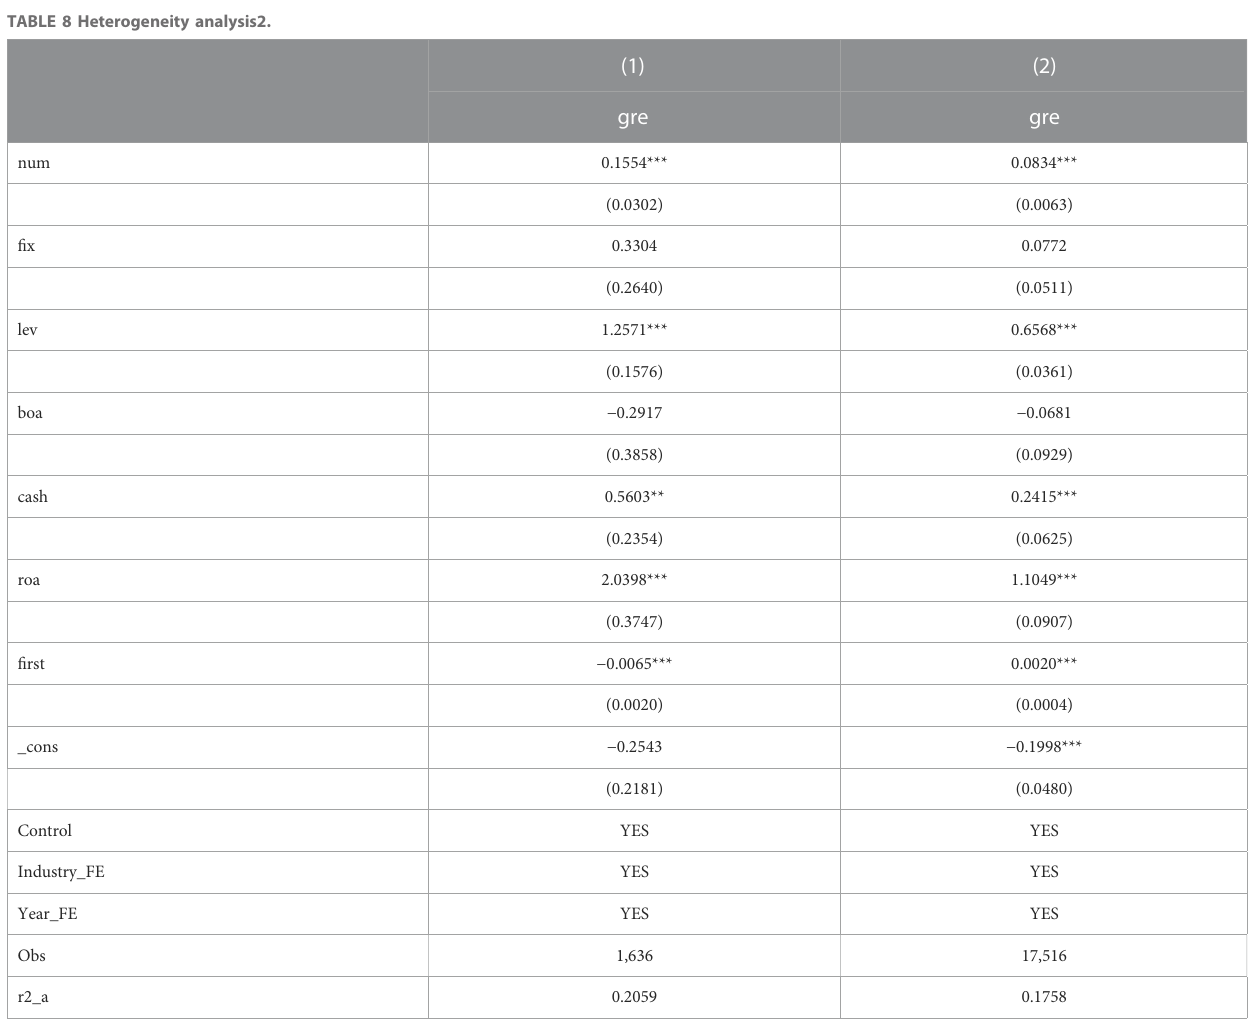
TABLE 8 Heterogeneity